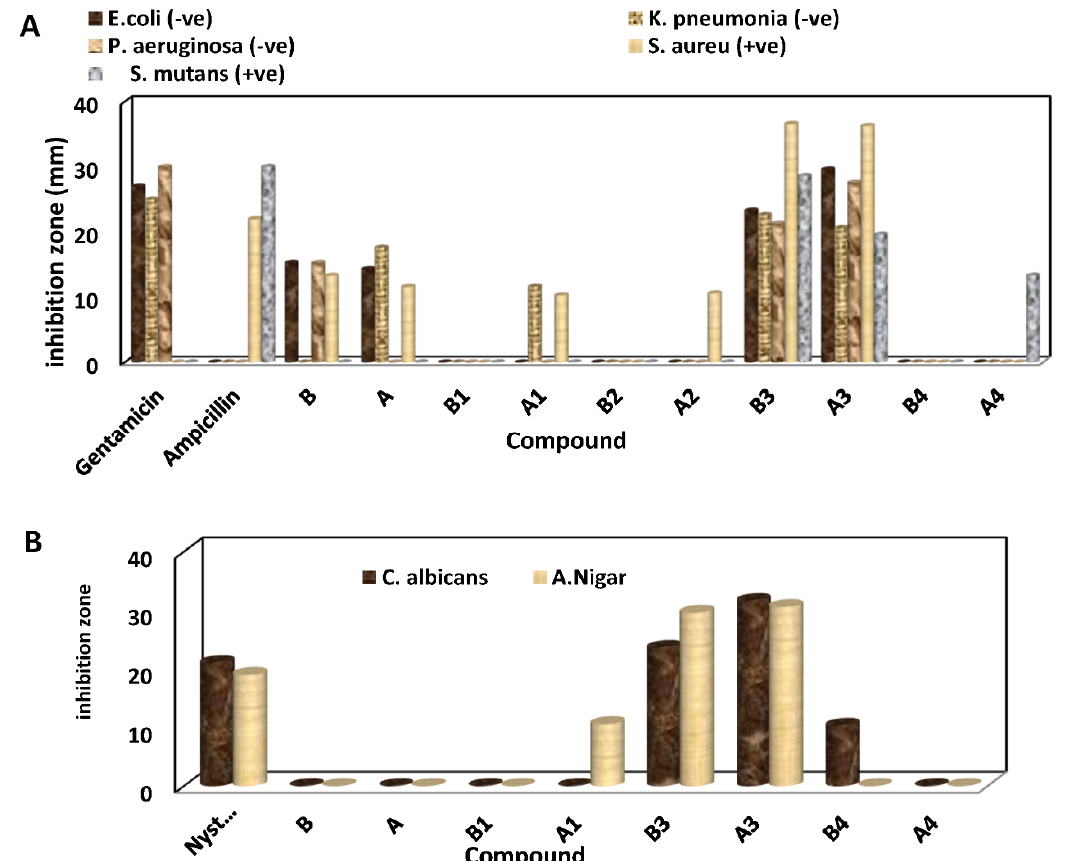
Table 9. Cytotoxic activity (IC 50 ) of the ligand and some metal complexes against human liver Hep- G2 and HEK-293 cell lines compared to vinblastine .